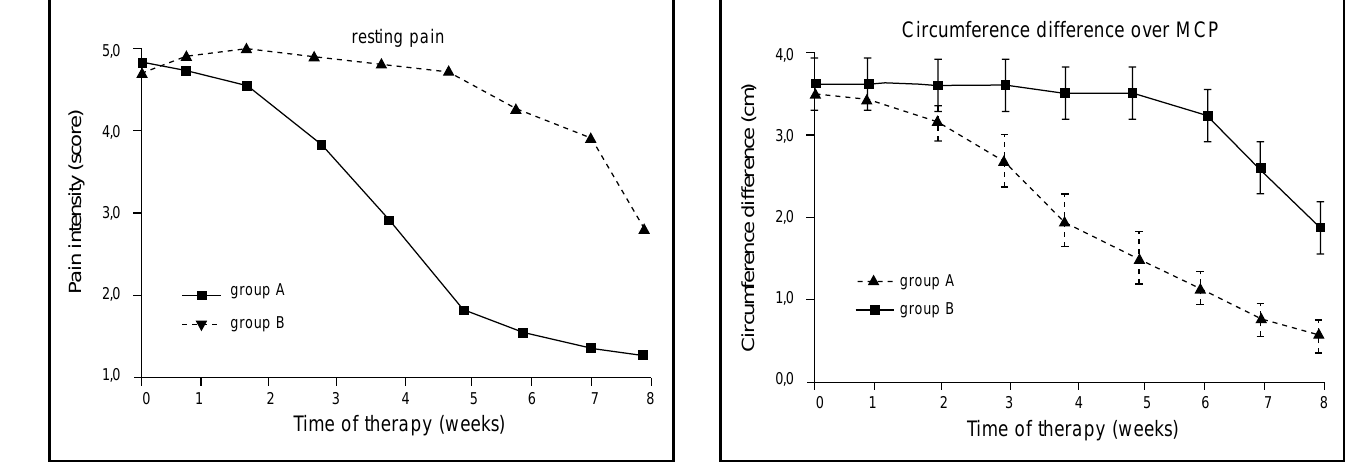
Figure 2: Resting pain in the course of the initial 8 weeks in the therapy groups (group A: n=20, group B: n=20).